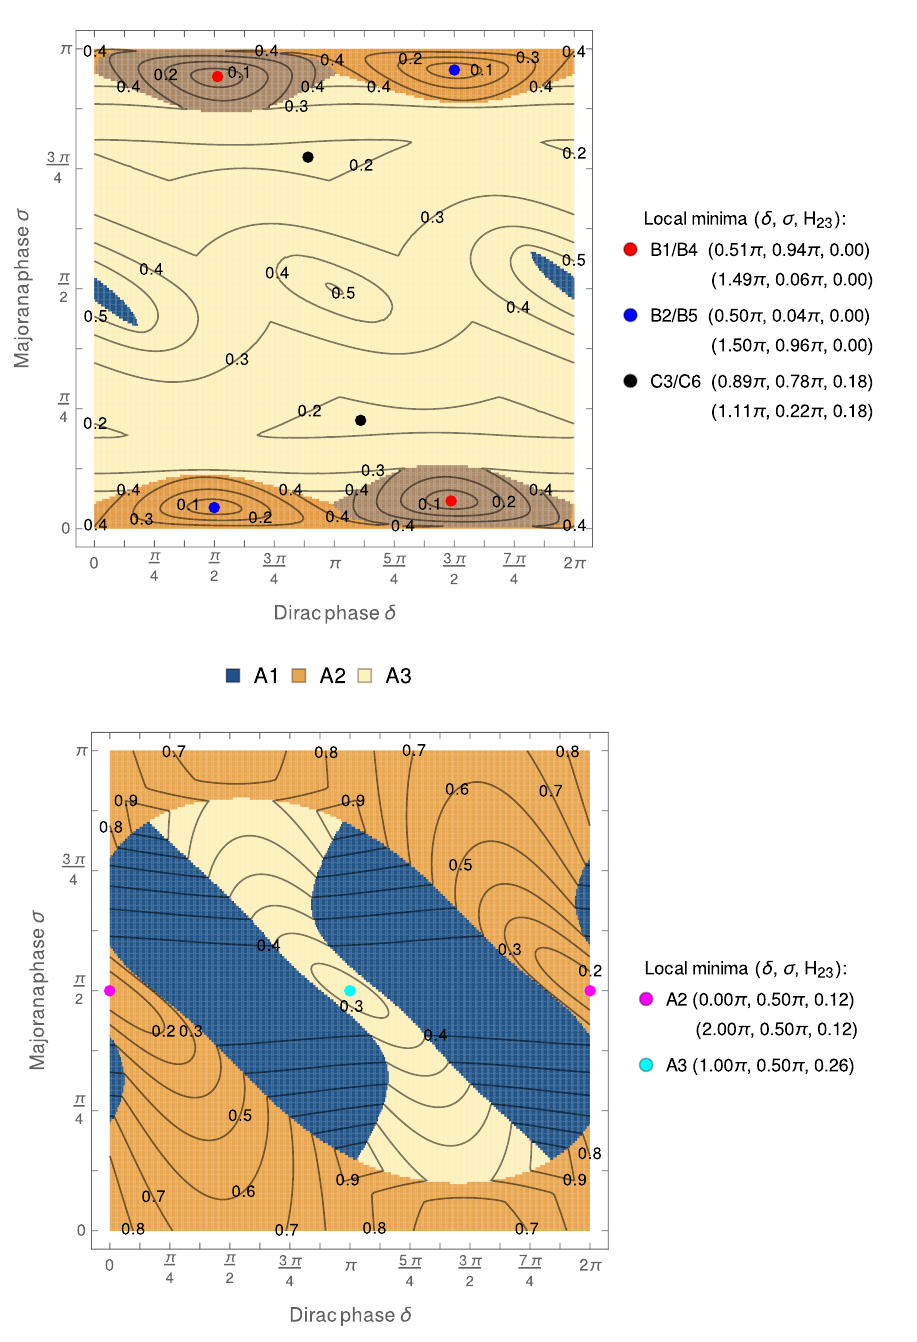
Figure 4 . Minimized hierarchy parameter H 23 as a function of the CP -violating phases (cid:14) and (cid:27) for inverted mass ordering , see eq. (4.1). The upper panel displays the results of minimizing R 23 only over values of j z I j of O (1) (no (cid:13)avor alignment), while in the lower panel , we plot the asymptotic (cid:8) (cid:9) value min R (cid:0) ; R + at j z I j (cid:29) 1 ((cid:13)avor alignment), see eq. (3.13). Contour lines, color shading, 23 23 colored points, and plot legends as in (cid:12)gure 2.